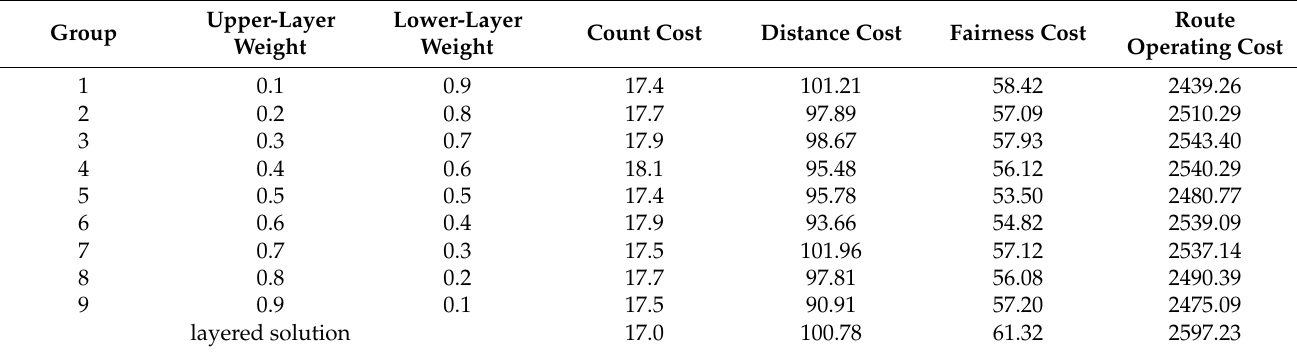
Table 10. Weight combination results in upper and lower